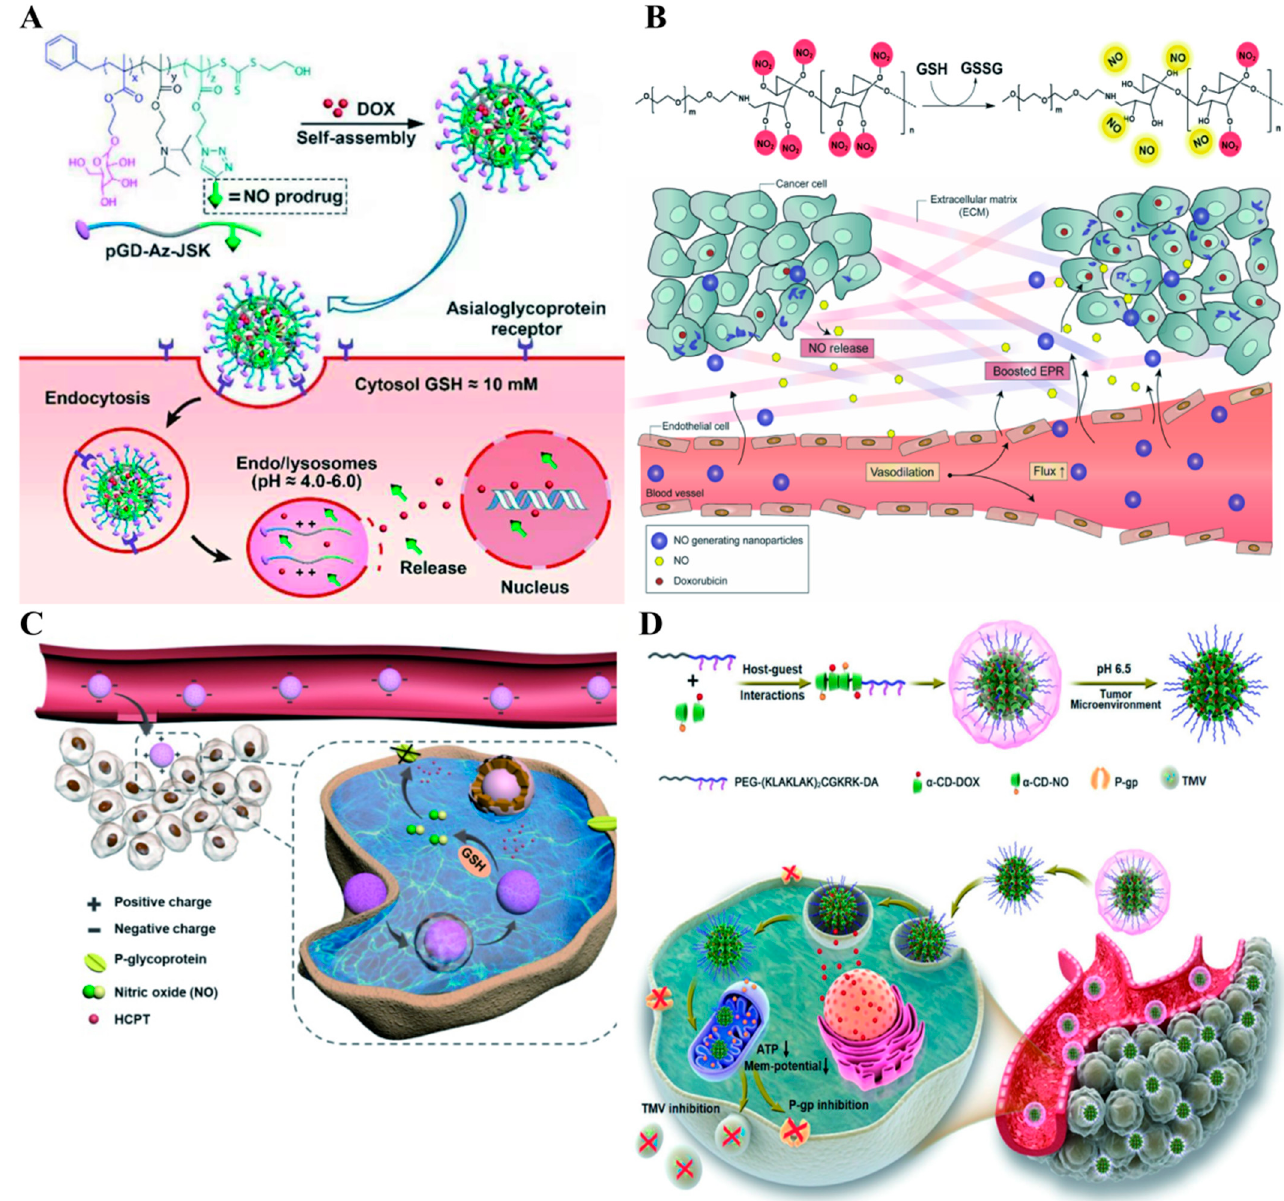
Figure 7. ( A ) Schematic diagram of the structure and preparation of the p(Gd-Az-JSK) NPs and their delivery process. Reproduced with permission from [97], Nanoscale, 2018; ( B ) schematic diagram of PEG-b-NO-Dex nanoparticles releasing NO and boosting EPR in the presence of GSH. Reproduced with permission from [98], Nano Letters, 2018; ( C ) schematic diagram of the structure and preparation of the HCPT/CTS–NO–DMMA NPs and its delivery process. Reproduced with permission from [99], Nanomedicine, 2019; and ( D ) schematic diagram of preparation of the α -CD–DOXNO–DA NPs and the process of exerting anti-tumor effects in cancer cells. Reproduced with permission from [100], Small, 2020.